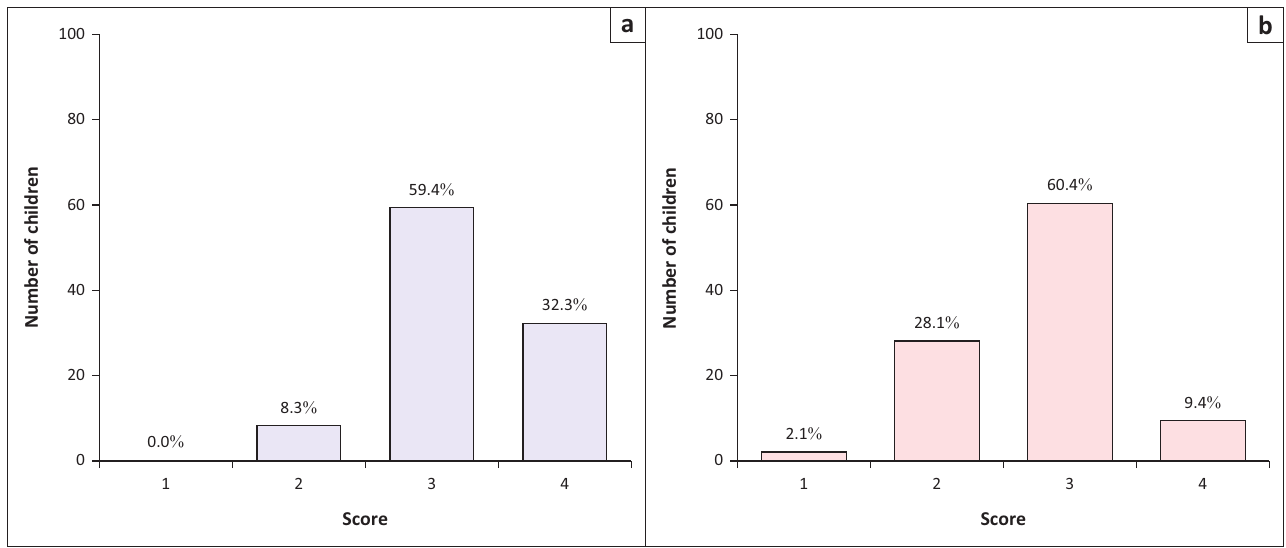
FIGURE 1: Bar graph representing reading performance scores of (a) learners in the group that participated in the music instruction programme and (b) learners in the group that did not participate in the music